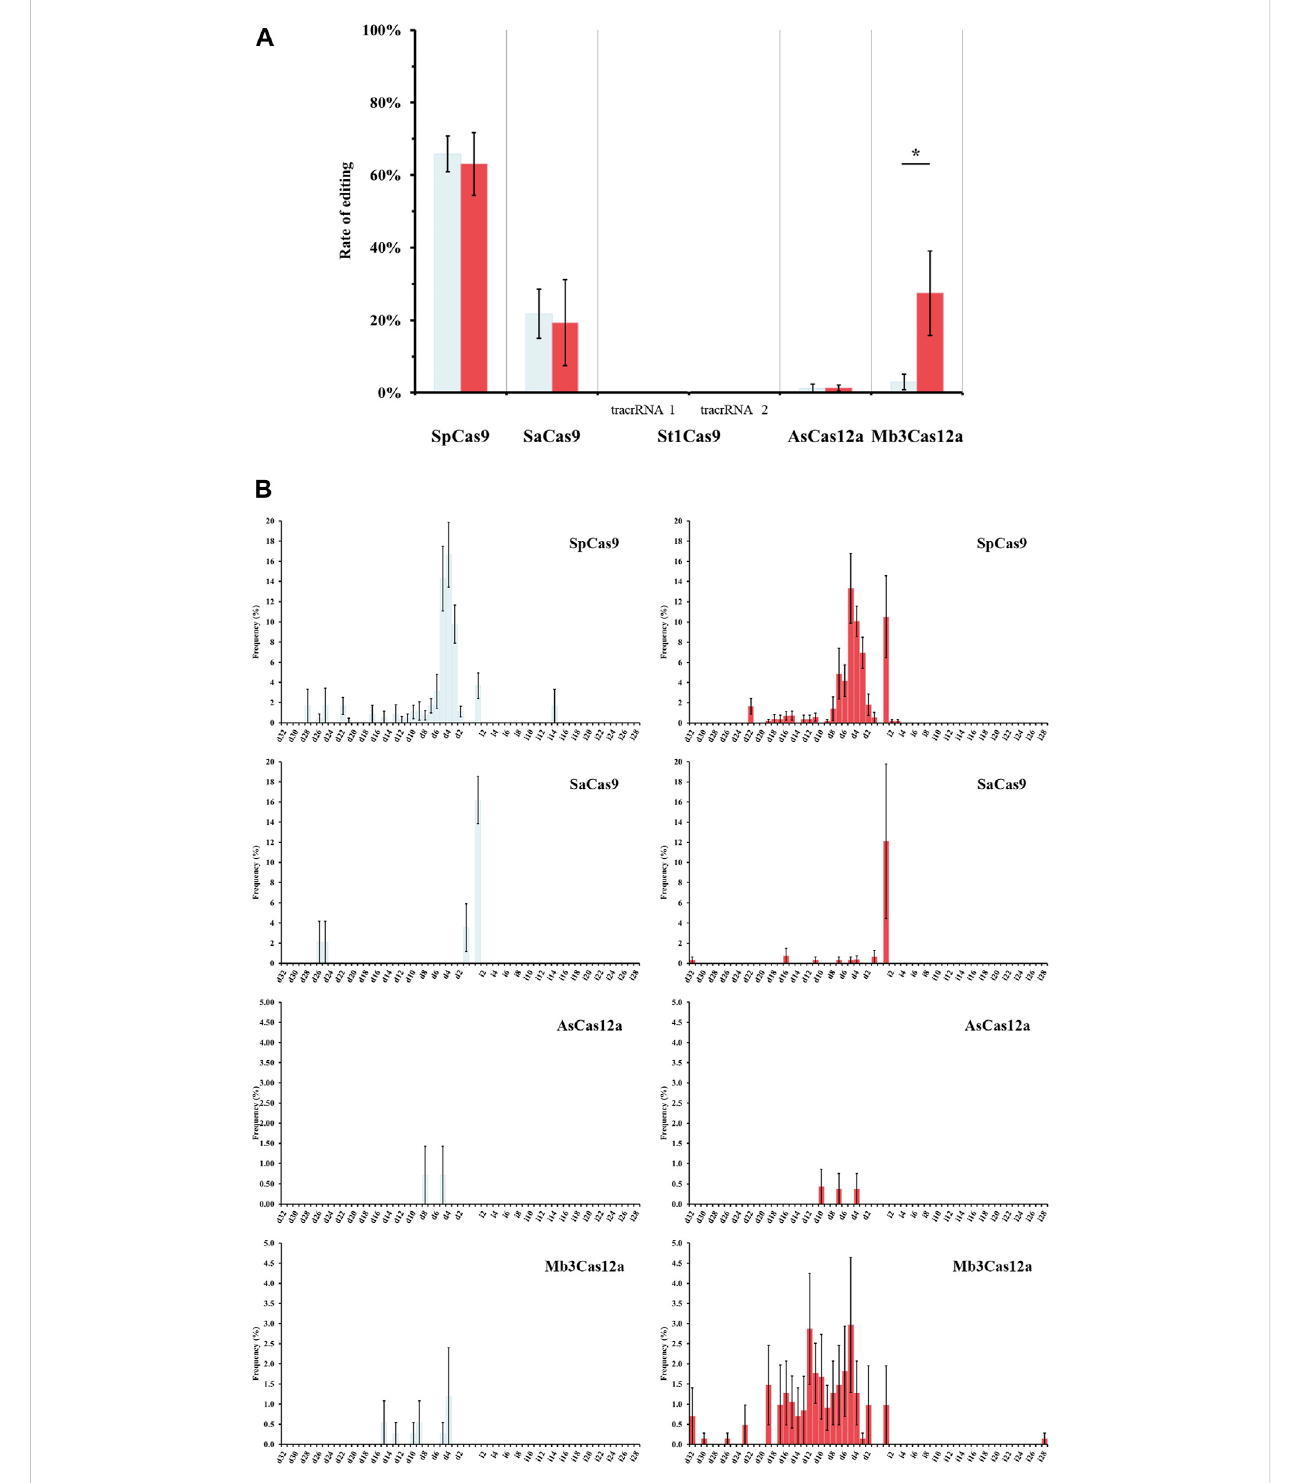
FIGURE 3 Gene editing ef fi ciency of different Cas effectors via Illumina sequencing. (A) Editing frequencies of rice phytoene desaturase (OsPDS) gene under differenttemperatures, 27 ° C (light blue) and 37 ° C (red). Bar graphs show the percentage of PDS gene edits as identi fi edby short-read sequencing. Trans- activating CRISPR RNA (tracrRNA) 1 and tracrRNA 2 were reported by Esvelt et al. (2013) and Briner et al. (2014), respectively. Signi fi cance p -value levels according to t-test are shown as < 0.05 (*). (B) Indel size pro fi les. Occurrence of deletion (d) and insertion (i). Frequencies (as percentage shown in the y -axis) were calculated using the number of edited alleles with N bp deletions or insertions by the number of all the alleles identi fi ed by sequencing. Graphs depict means and error bars show standard error of the mean (SEM) from 5 replicates. Results from St1Cas9 are not shown due to the lack of